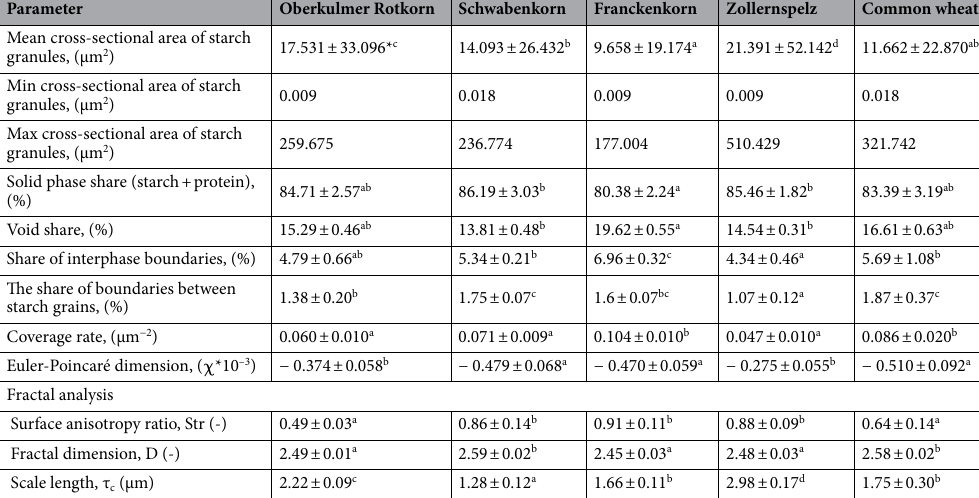
Table 2. Morphological properties of grain endosperm of spelt and common wheat. *Values given as the average values ± standard deviation (SD). Values marked with the same letters in rows are not significantly different at p ≤ 0.05.